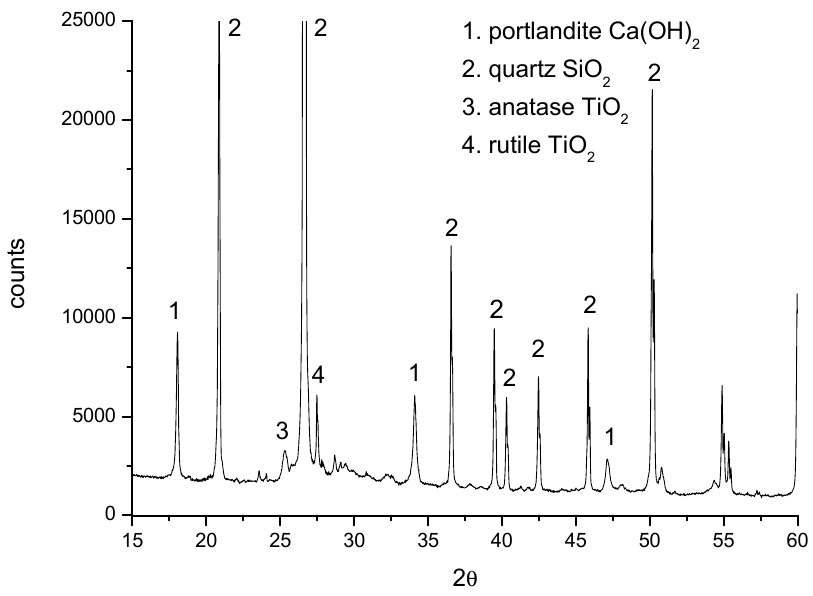
Figure 2. X-ray di ff raction (XRD) of G-10.